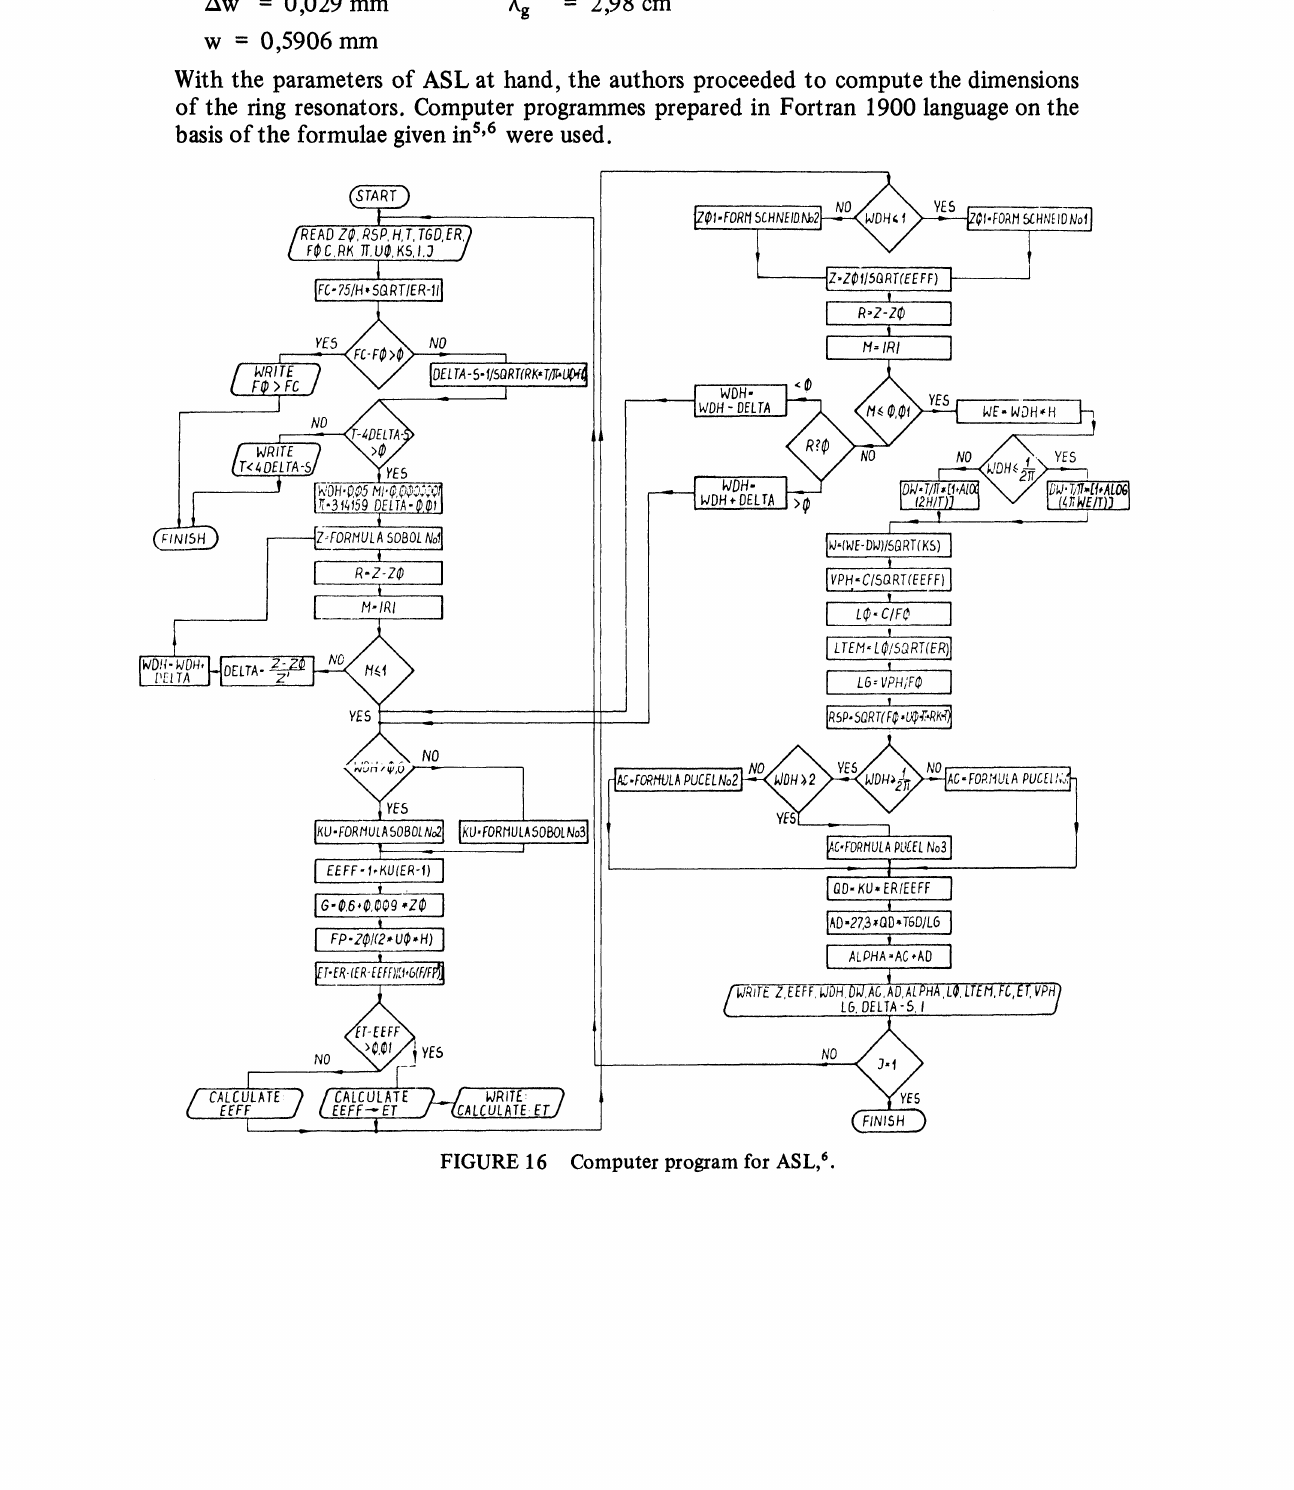
FIGURE 16 Computer program for ASL,